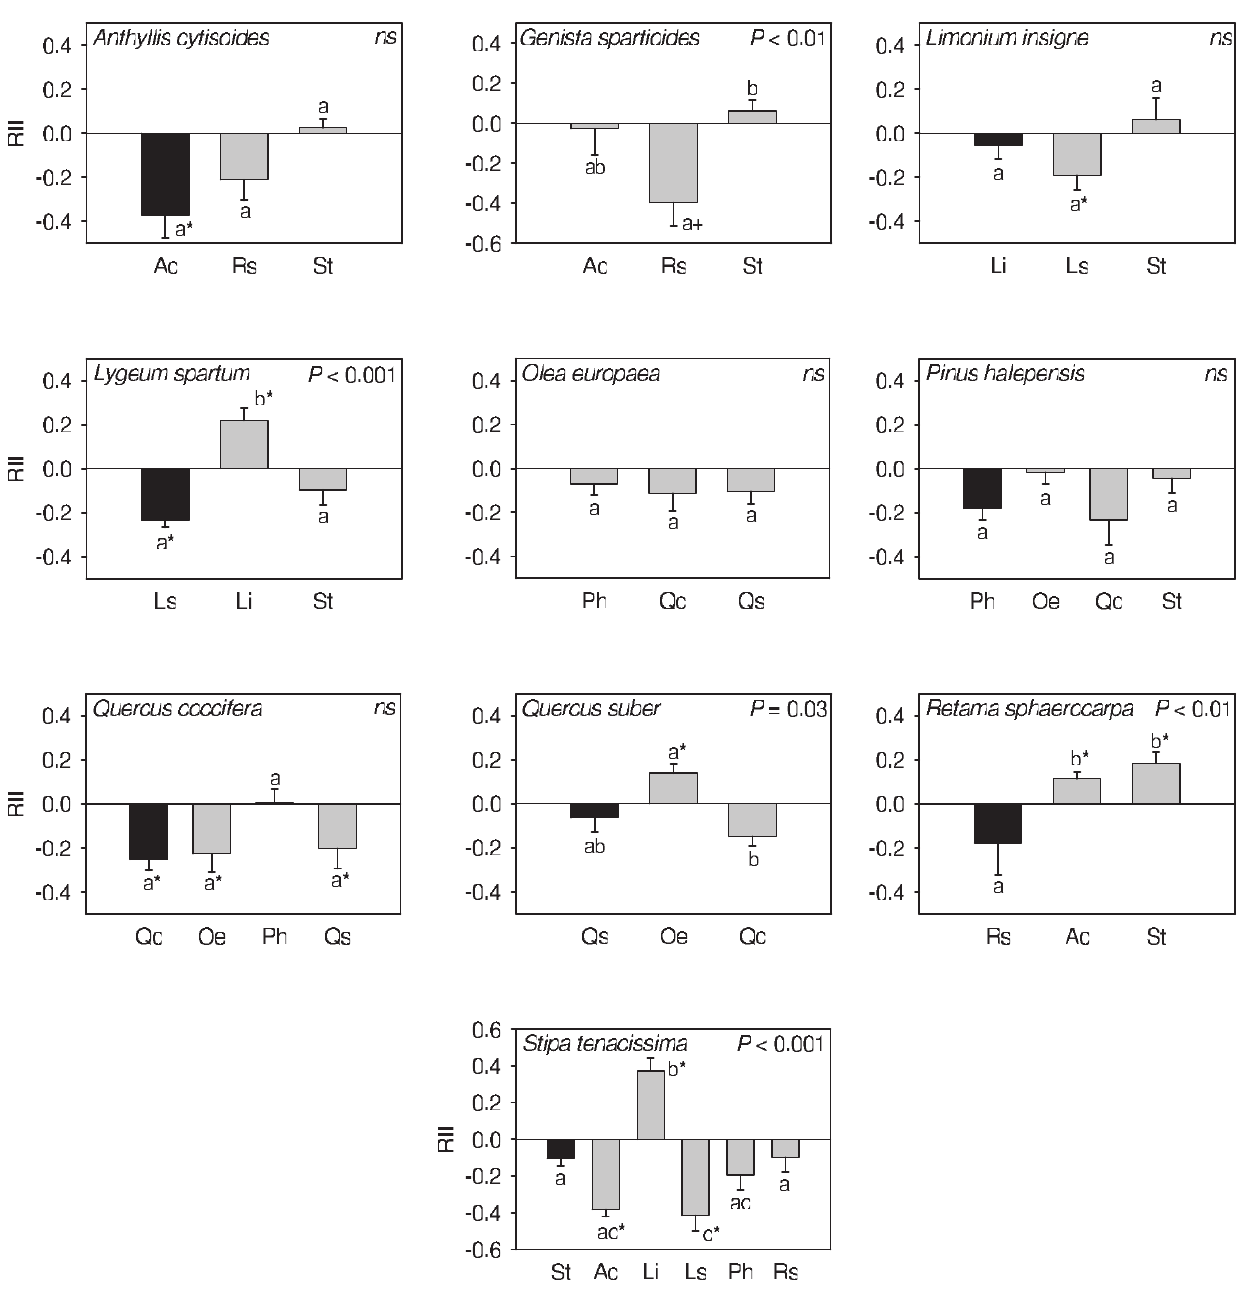
Figure 3. Net effect of target species on neighbour species. Intensity of the effects ( RII ) of species (name inside the panel) on individuals of the same (solid column) or different species (grey columns). P is the significance of ANOVA ( ns : non-significant differences). Bars with different letters are significantly different at P , 0.05. Asterisk and crosses denote, respectively, significant (* P , 0.05) and marginally significant ( + P , 0.07) differences with control plants, i.e. target species competed with or facilitated its neighbour. Legend of species is as in Table